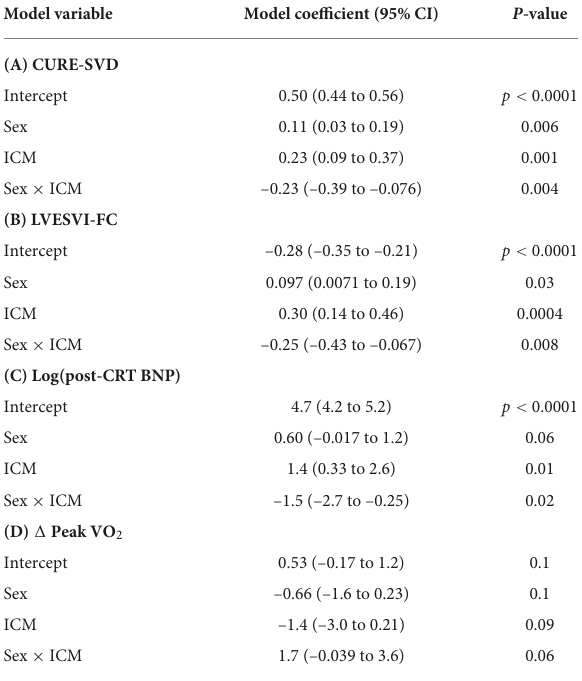
TABLE 2 Linear regression models with interaction term.